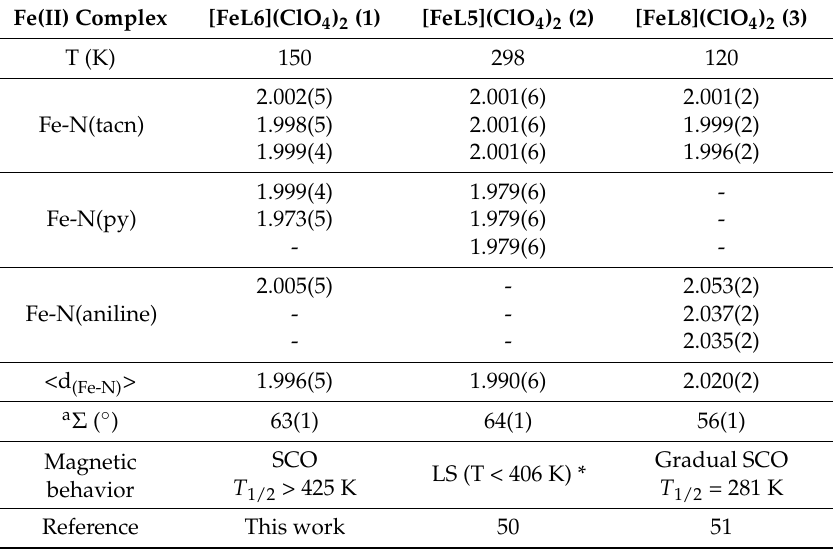
Table 3. Fe-N distances (Å) and magnetic properties of the reported Fe(II) tacn N-functionalized macrocycle based complexes (see Scheme 1 for L5, L6, and